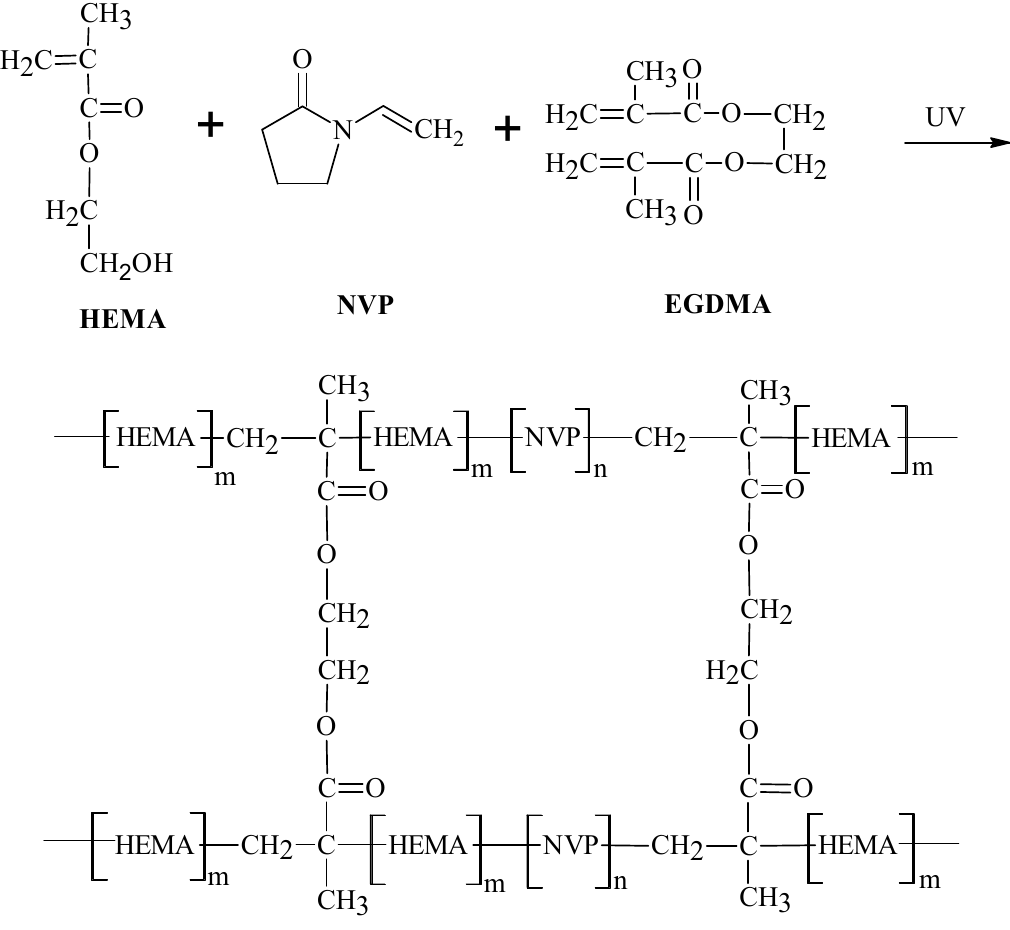
Figure 1. The reaction of poly(HEMA- co -NVP) lenses.